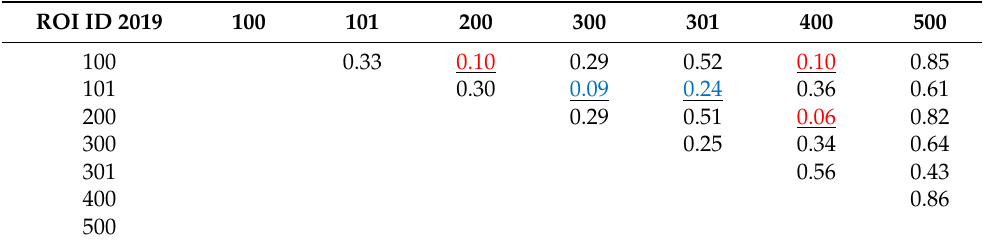
Table 8. Test separability of ROI with JM, low values are underlined (JM low values between summer crops in red and JM low values between multi-modal TS profiles in blue).